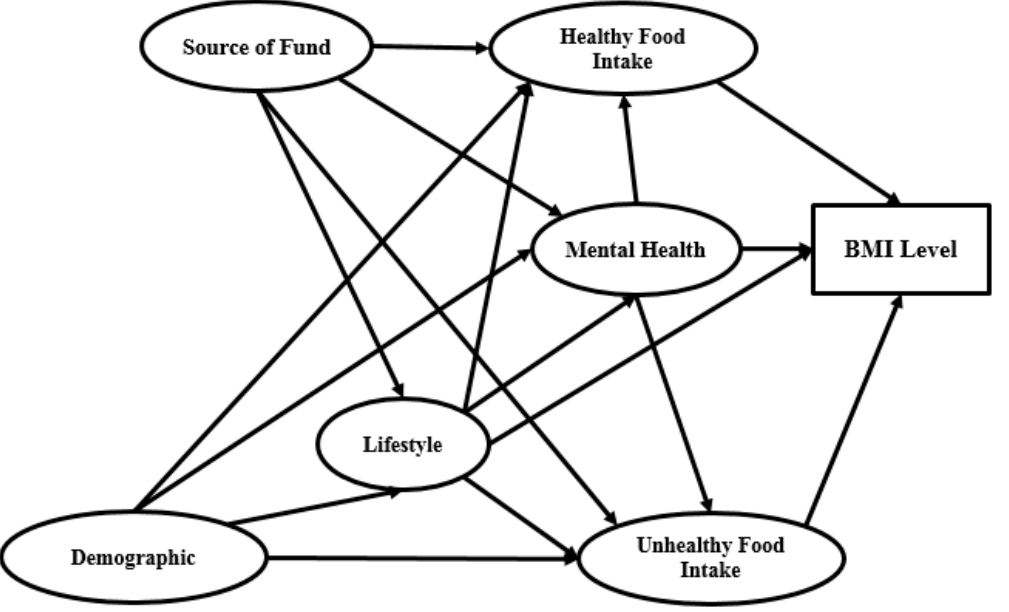
Figure 1. Graphical research model for SEM (Structural Equation Modelling) analysis (BMI: Body Mass Index).